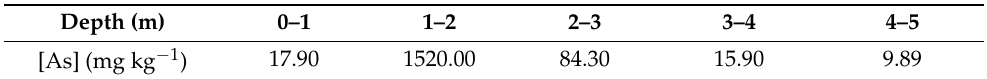
Table 1. As concentrations detected in the 5 different depth levels of the core extracted during a previous investigation.